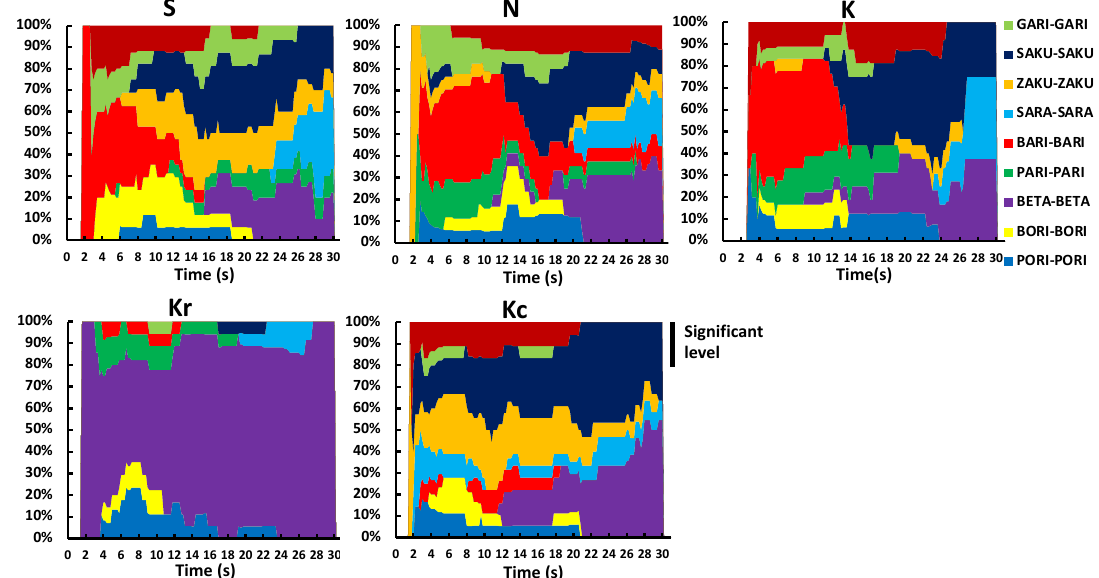
Figure 7. TDS band plots for each sample in Experiment 2. Samples S, K, and N are available commercially and produced by different manufactures. Sample Kr was a moisturized and re-dried version of K, and Kc was a crushed version of K. TDS, temporal dominance of sensations.